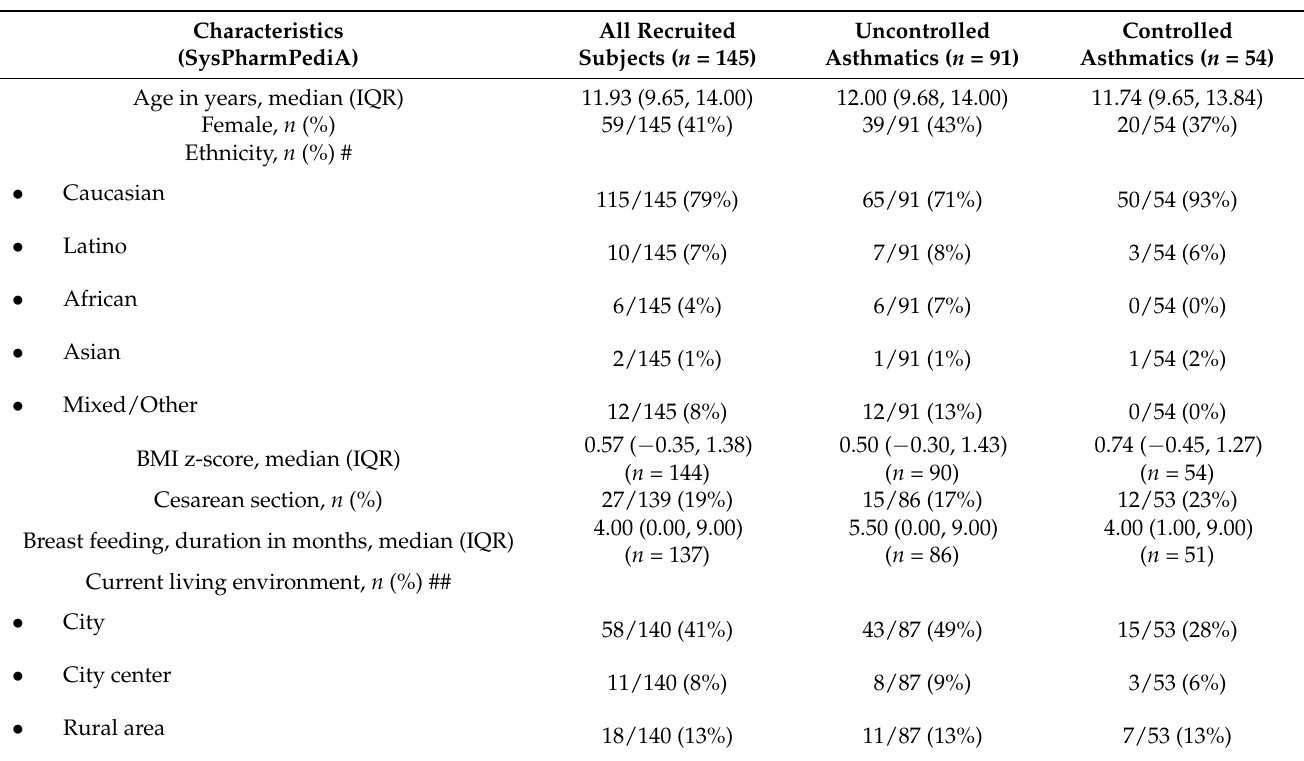
Table 1. Baseline characteristics for the study